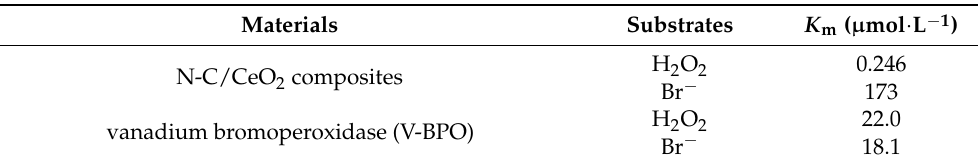
Table 2. Comparison of the apparent Michaelis–Menten constant and maximal reaction rate between the N-C/CeO 2 composite and